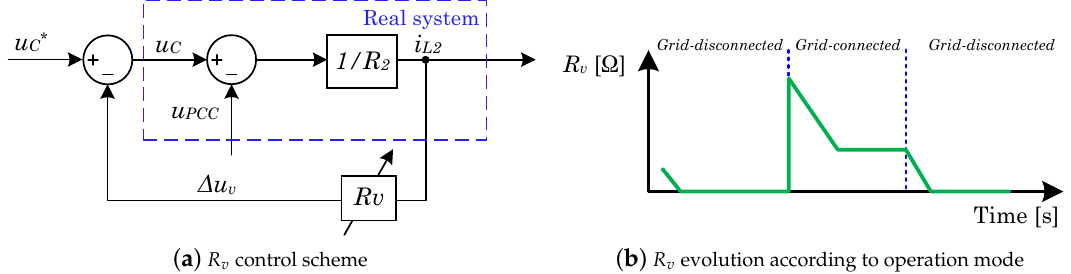
Figure 4. The virtual resistance R v operation.